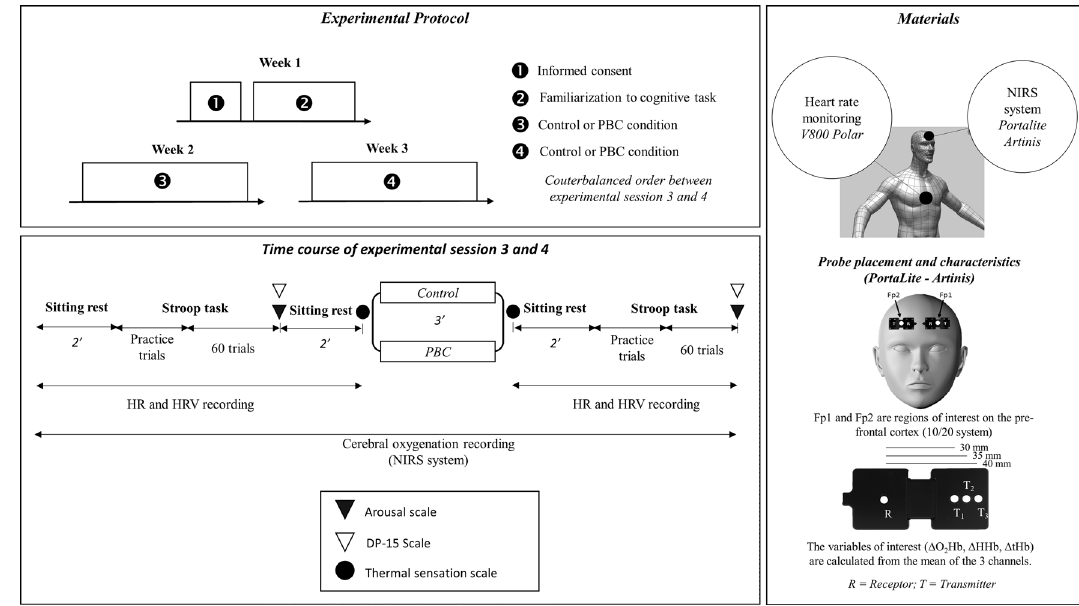
Figure 1. Schematic of the experimental protocol. PBC partial body